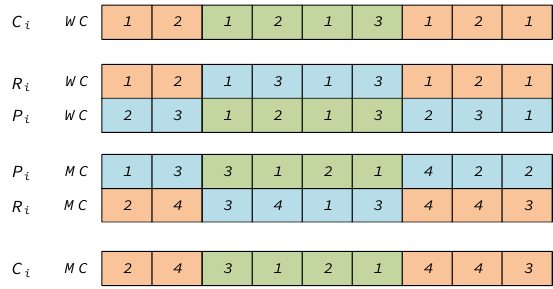
Figure 5. Cross-updating process for individual machine–worker.